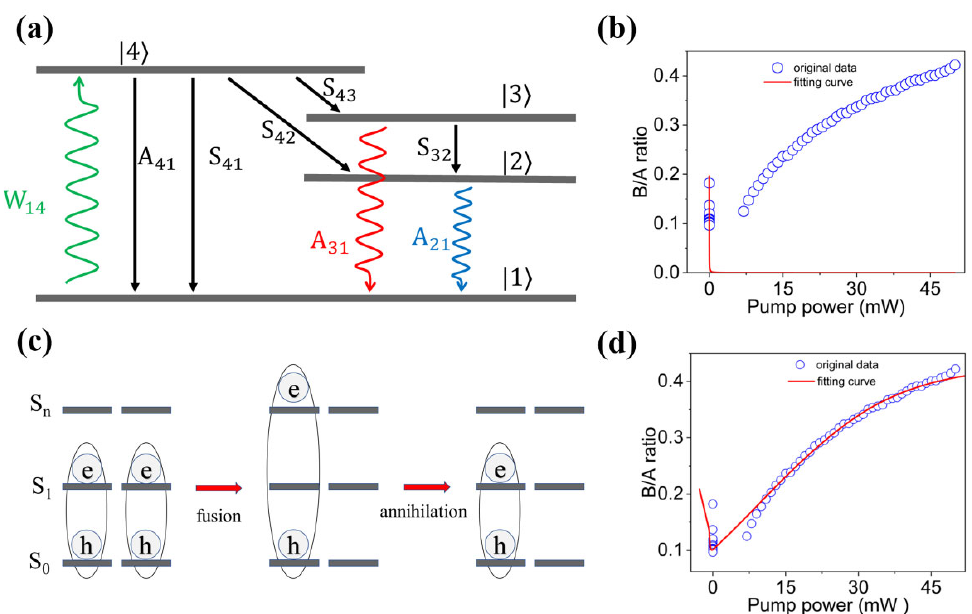
Figure 4. ( a ) The PL spectra of the monolayer MoS 2 under pump light with low power ranging from 1.875 to 7.85 μ W. ( b , c ) The intensity variations of ( b ) A ‐ exciton and ( c ) B ‐ exciton under increasing pump power. ( d ) The ratio variation of B/A intensity ratio under increasing pump power.